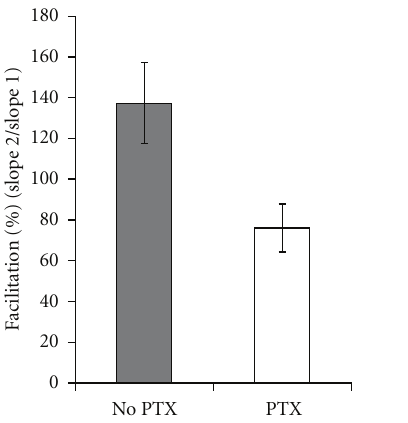
Figure 4: Paired-pulse facilitation was converted to paired-pulse depression by picrotoxin in the CA3 region. The average PPR without picrotoxin was 137 . 3 ± 19 . 8% ( n = 4), but the average PPR with picrotoxin was 76.1% ± 11.8% ( n = 8).